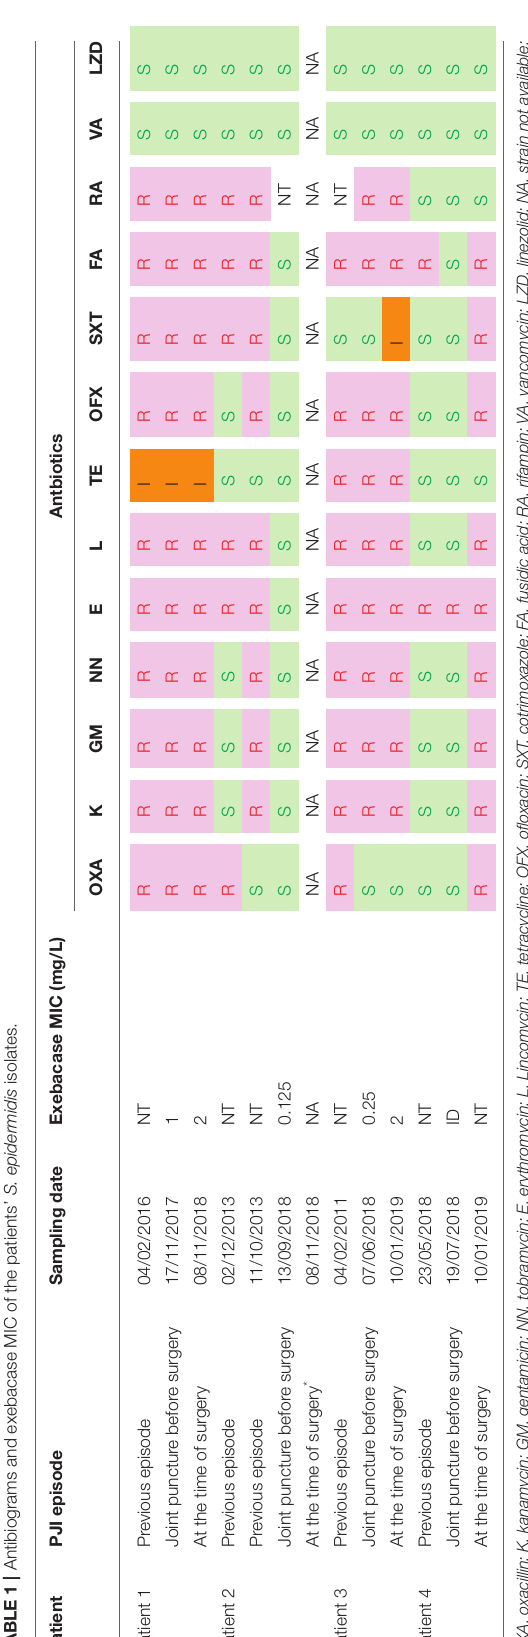
were within the range of 0.125–2 µ g/mL previously reported for S. epidermidis